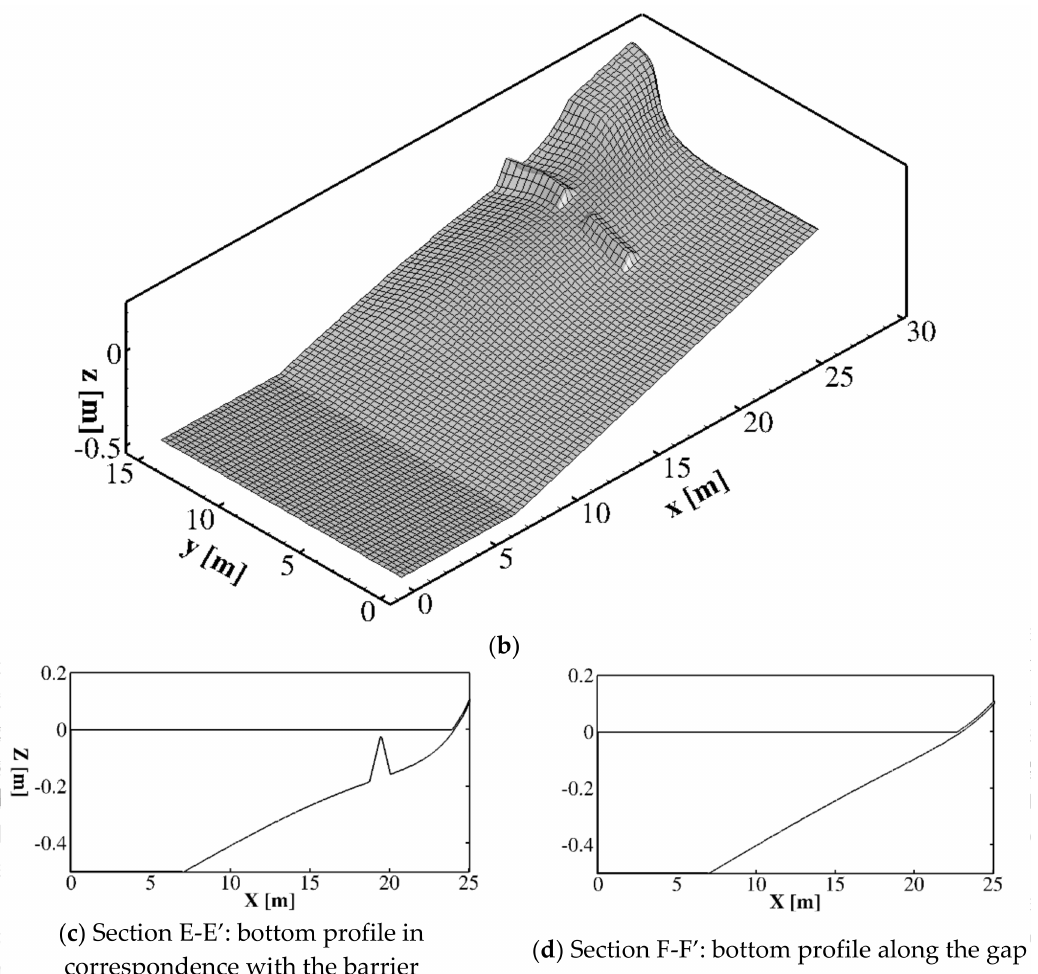
Figure 10. Case 2: ( a ): Plan view of the curvilinear computational grid (Only one out of every five coordinate lines is shown). ( b ): three-dimensional view of the bottom. ( c – d ): bottom profiles in section C-C’ and